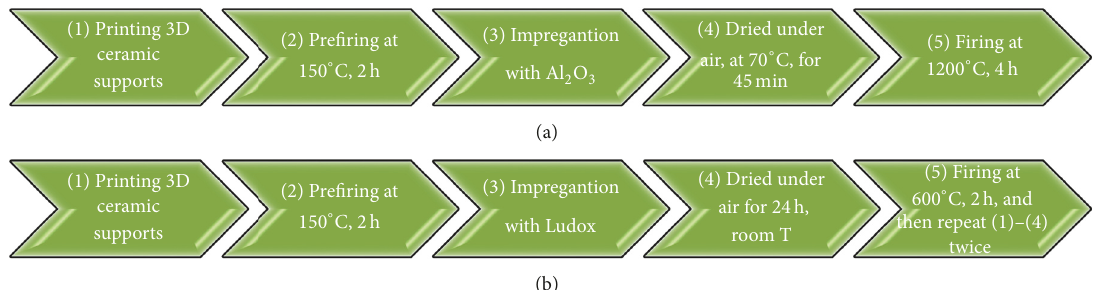
Figure 4: Schemes for improving the mechanical stability of 3D printed supporting structures using two alternative impregnation routes: (a) route 1 with Al 2 O 3 and (b) route 2 with Ludox